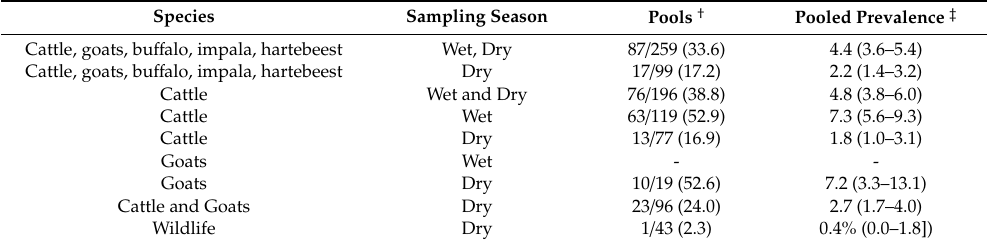
Pools † Pooled Prevalence ‡